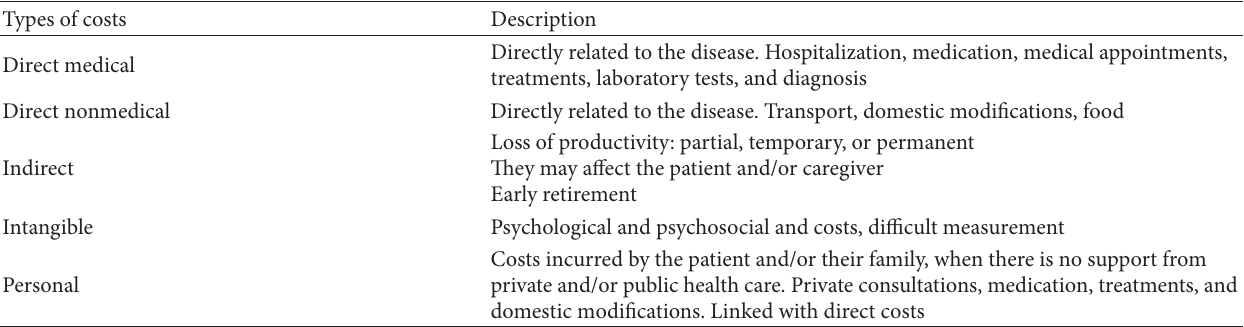
Table 3: Classification of